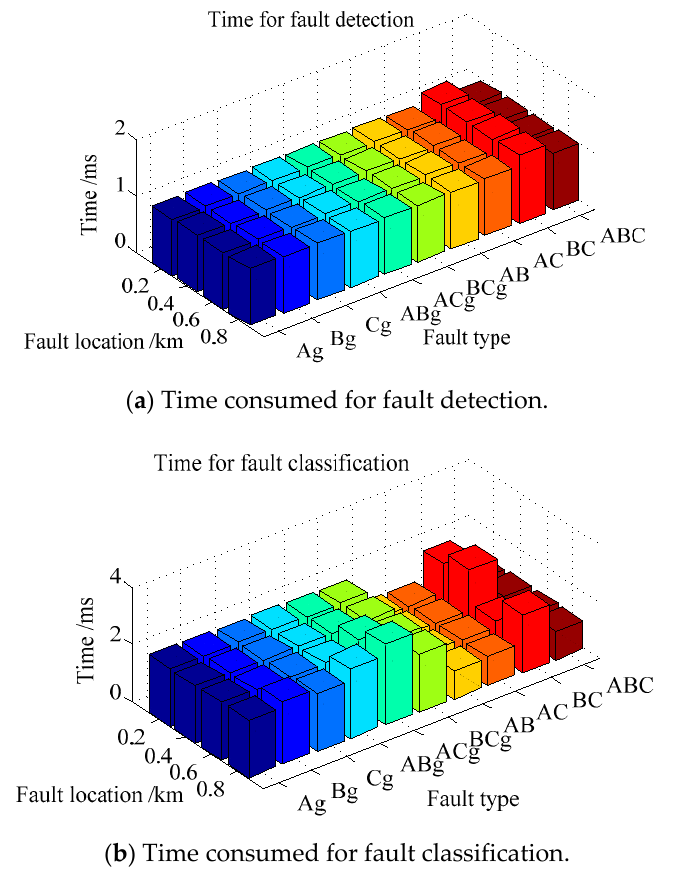
Figure 8. Simulation result of the power-load section.